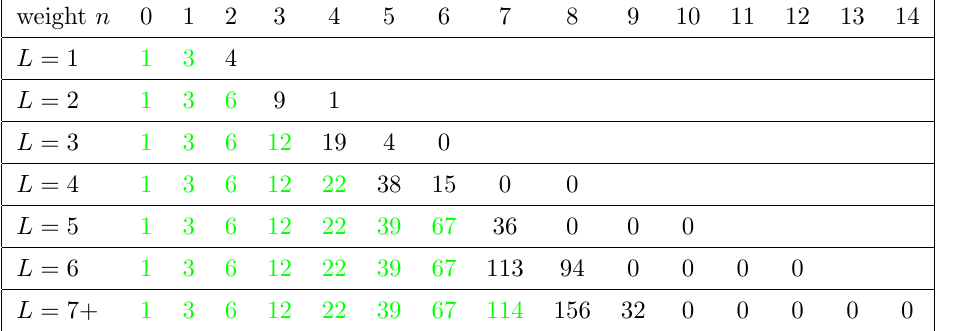
Table 6 . Same as table 4, but just for the parity even K functions that do not contain y i in their symbols. Note that for loop order L > 2, the (cid:12)rst L (cid:0) 2 coproducts of the amplitudes do not include any K